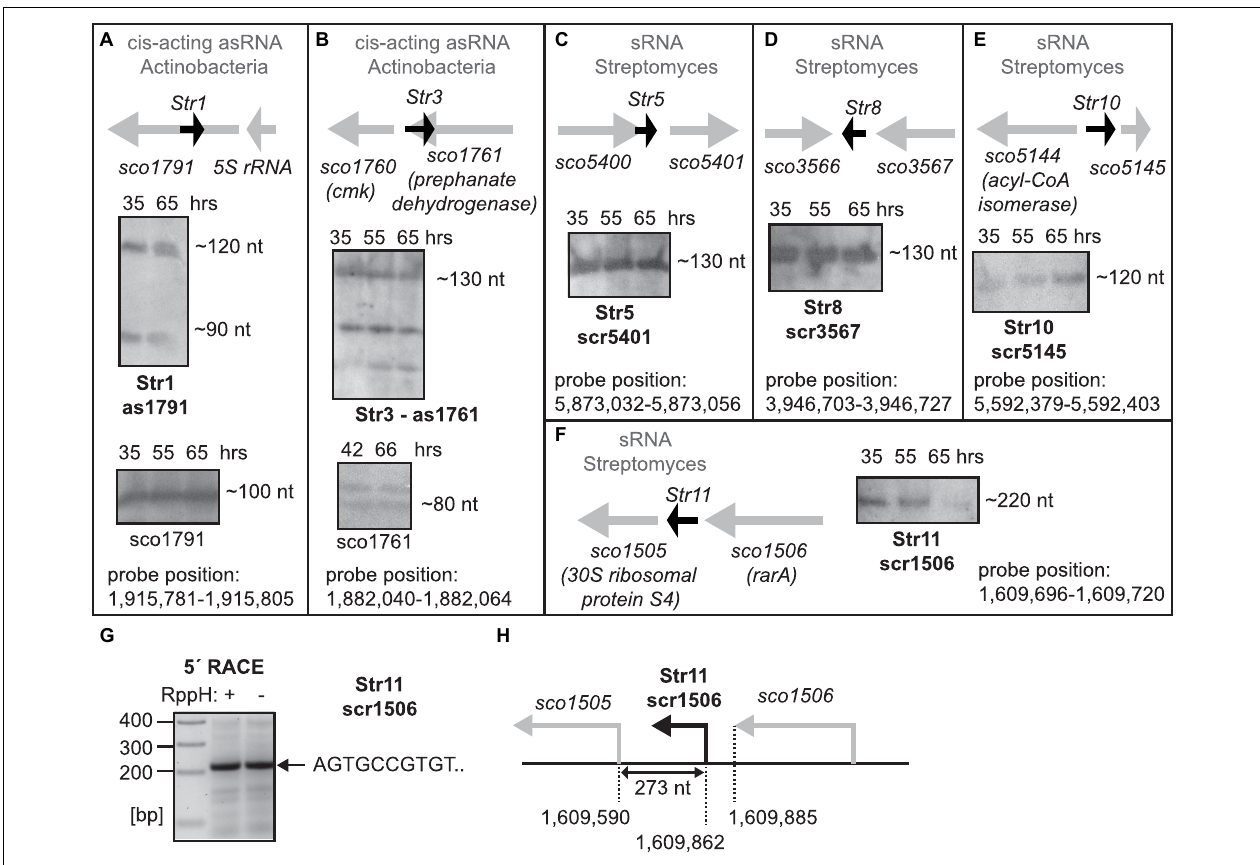
FIGURE 1 | (A–F) Expression of predicted sRNAs. Total RNA was isolated from S. coelicolor at 35 (exponential phase of growth), 55 and 65 h after germination and the expression was detected by Northern blotting. 65 hours of growth represents stationary phase of growth. Orientation and the flanking genes are schematically shown for each sRNA. For as1791 and as1761 RNAs, fragments of sco1791 and sco1761 transcripts detected by Northern blotting are also shown in (A,B) . For scr1506, 5 (cid:48) ends was detected by 5 (cid:48) RACE (G,H) .